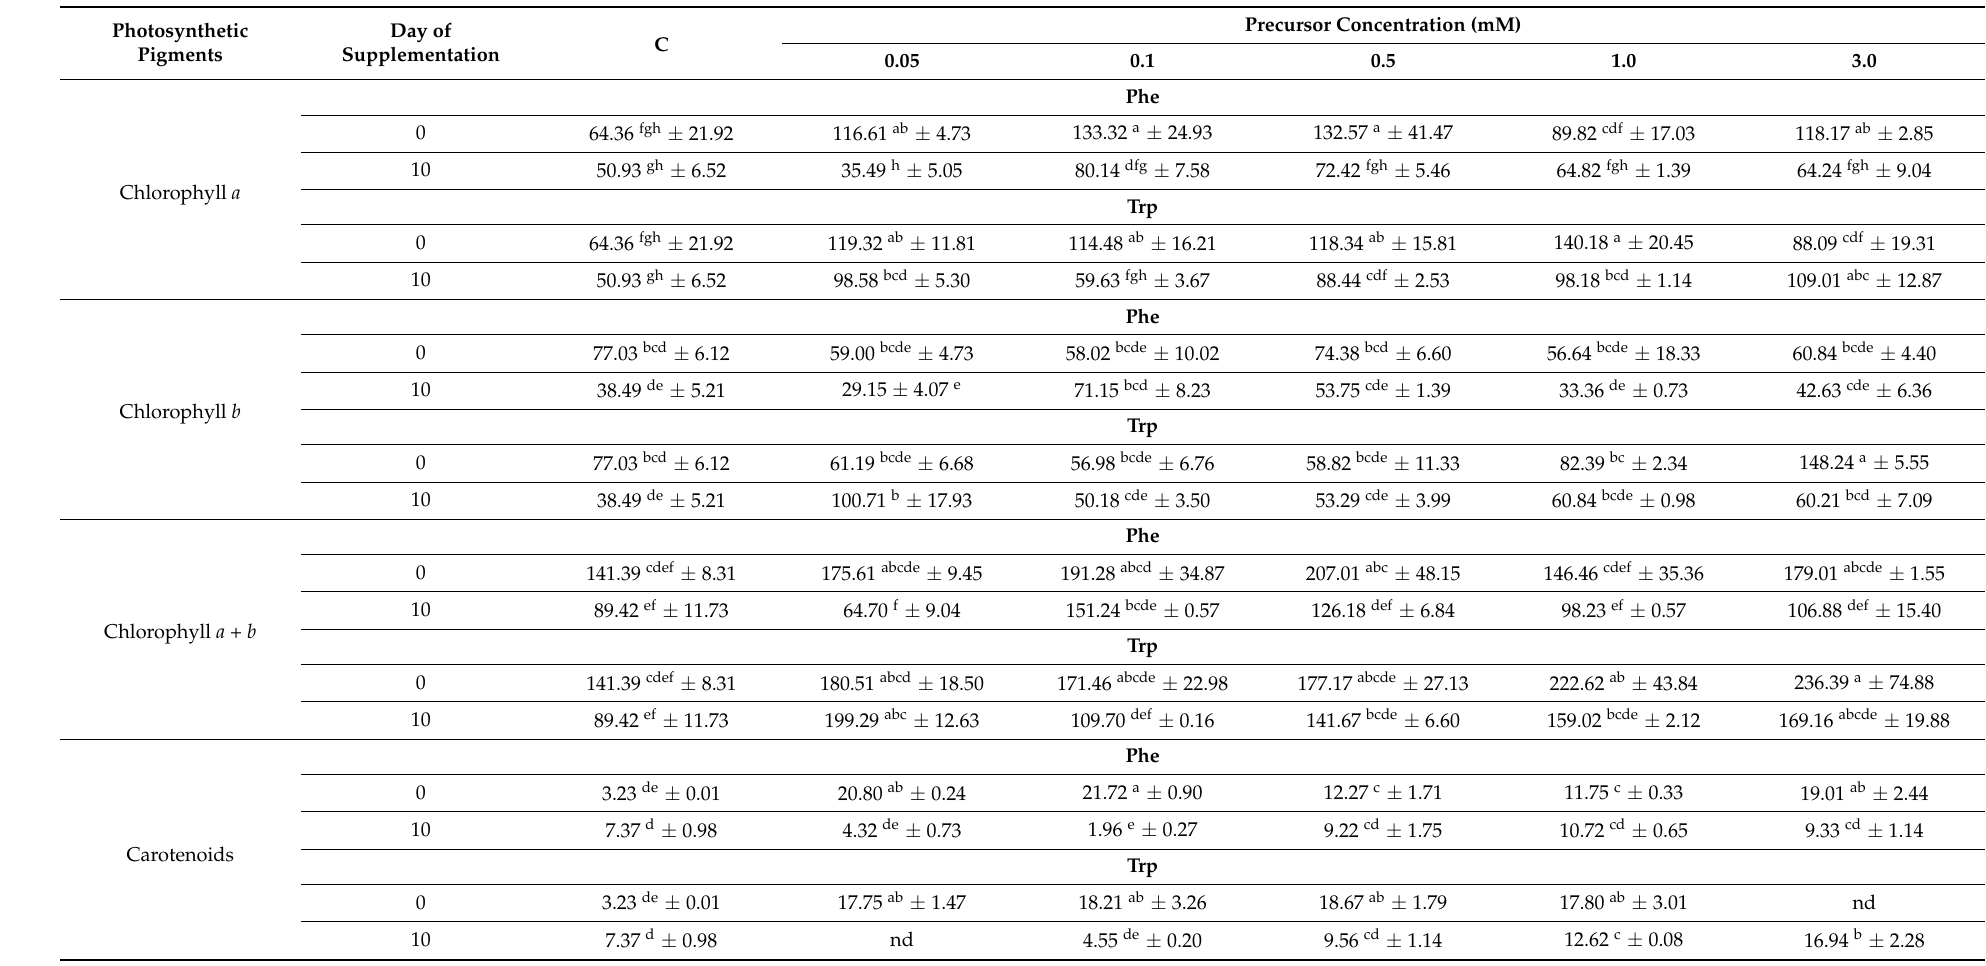
Table 3. Amounts of photosynthetic pigments (mg/100 g DW ± SD) in bioreactor-grown N. officinale microshoot cultures after precursor feeding. Photosynthetic